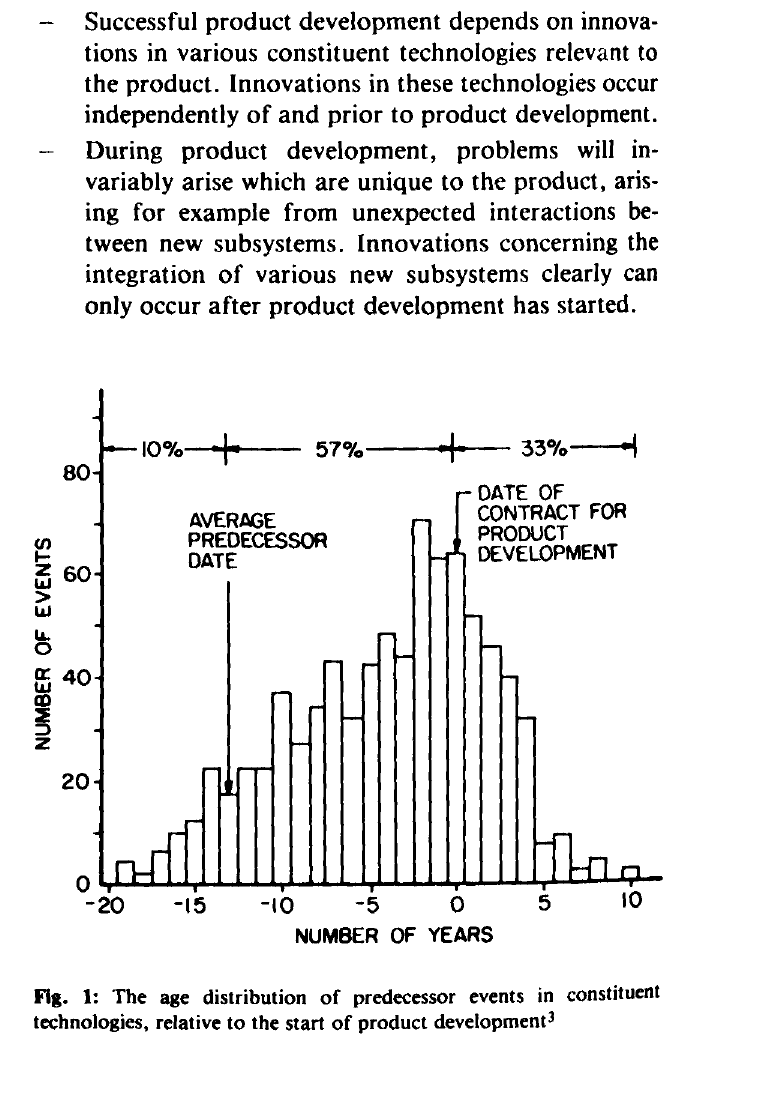
Fig. 1: The age distribution of predecessor events in constituent technologies, relative to the start of product development